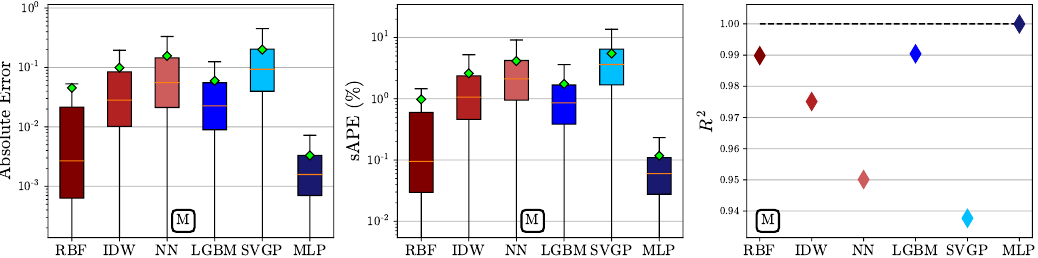
Figure 14: Boxplots of the absolute error (left) and symmetric absolute percent error (middle), and the R 2 metric (right) for the two-loop self-energy master integral M in 5 dimensions. Red colors indicate interpolation while blue colors indicate regression